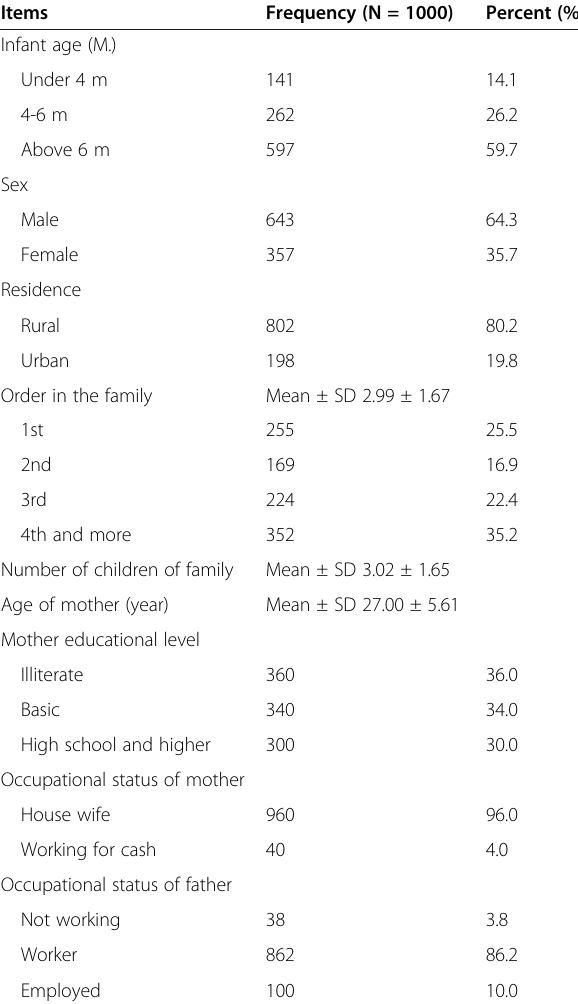
Table 1 Sociodemographic characteristics of the study